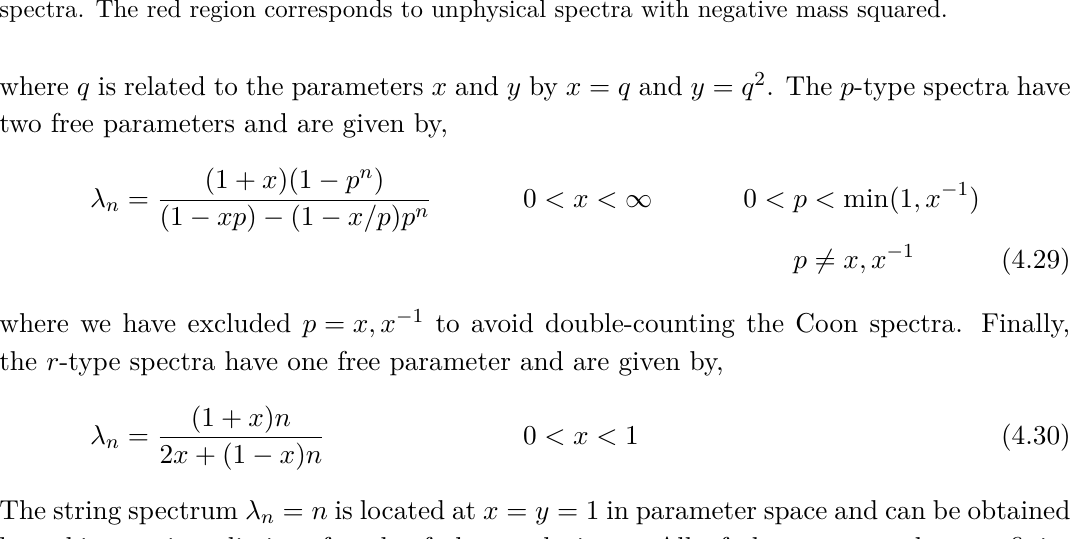
Figure 1 . The two-parameter space of solutions to the generalized Veneziano amplitude constraints. The point x = y = 1 corresponds to the string spectrum. The solid black line corresponds to the one-parameter subspace of Coon spectra. The dashed black line corresponds to the one-parameter subspace of r -type spectra. The yellow region corresponds to the two-parameter subspace of p -type spectra. The red region corresponds to unphysical spectra with negative mass